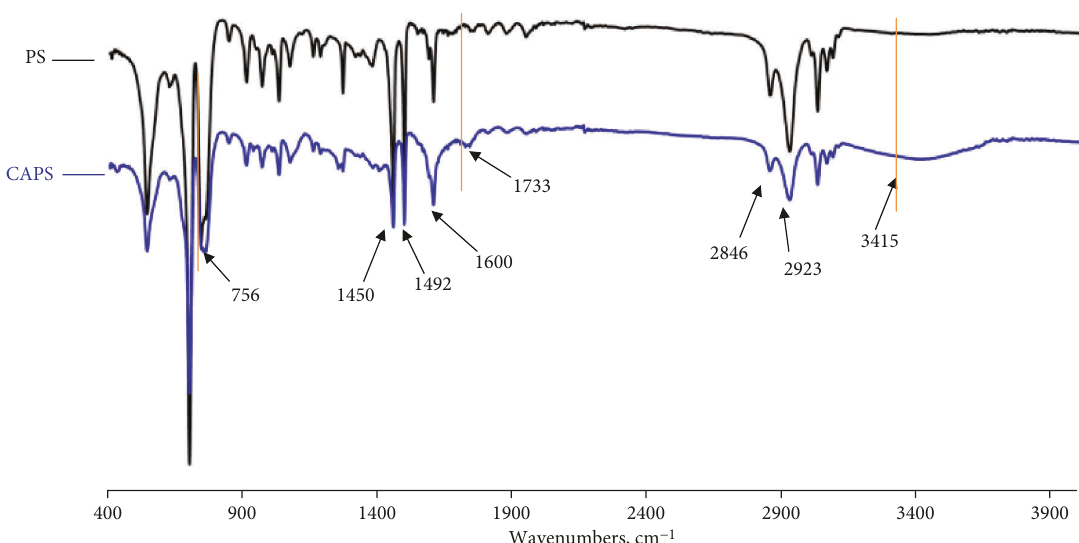
Figure 3: FT-IR spectra of cross-linking PS beads and polycarboxyl amino PS beads (CAPS).